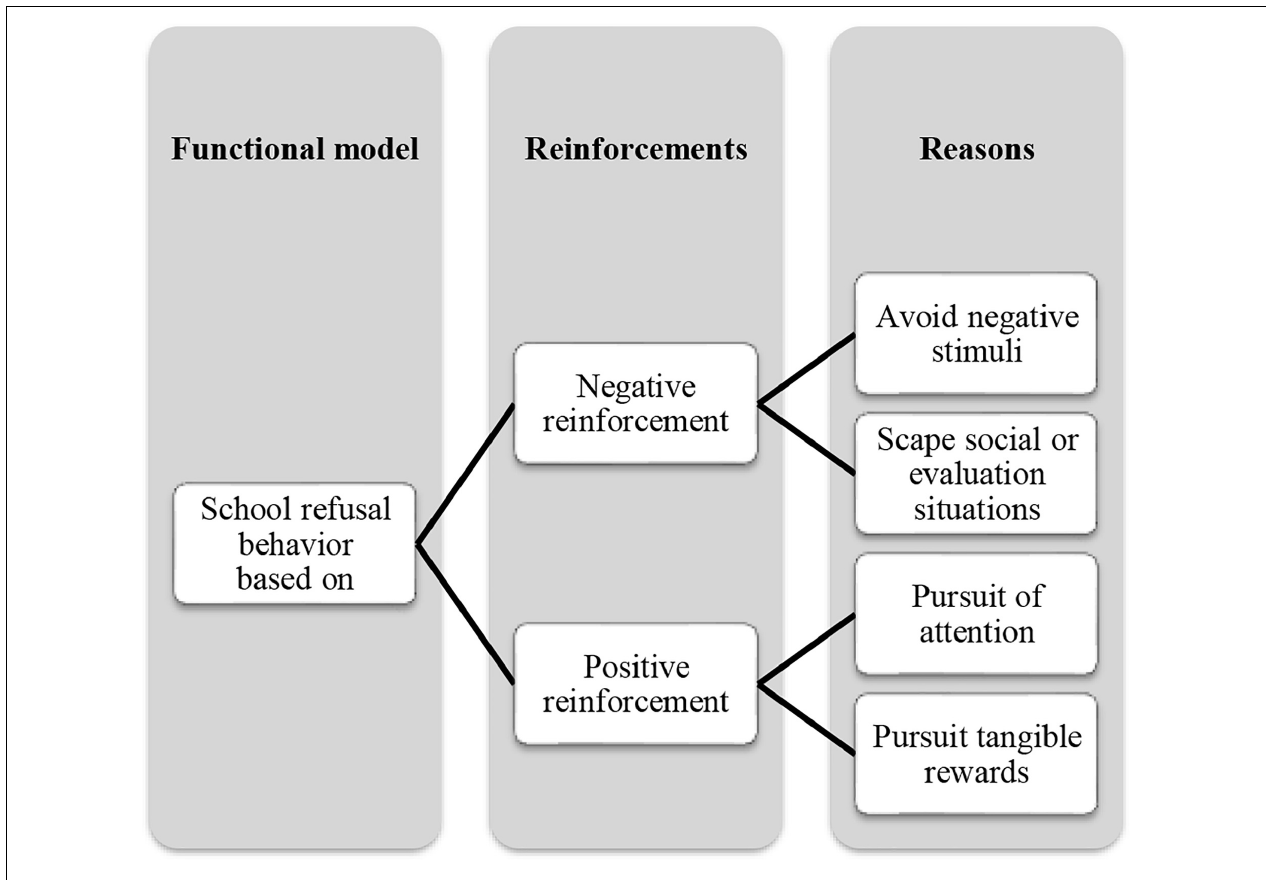
FIGURE 1 | Functional model of school refusal behavior.